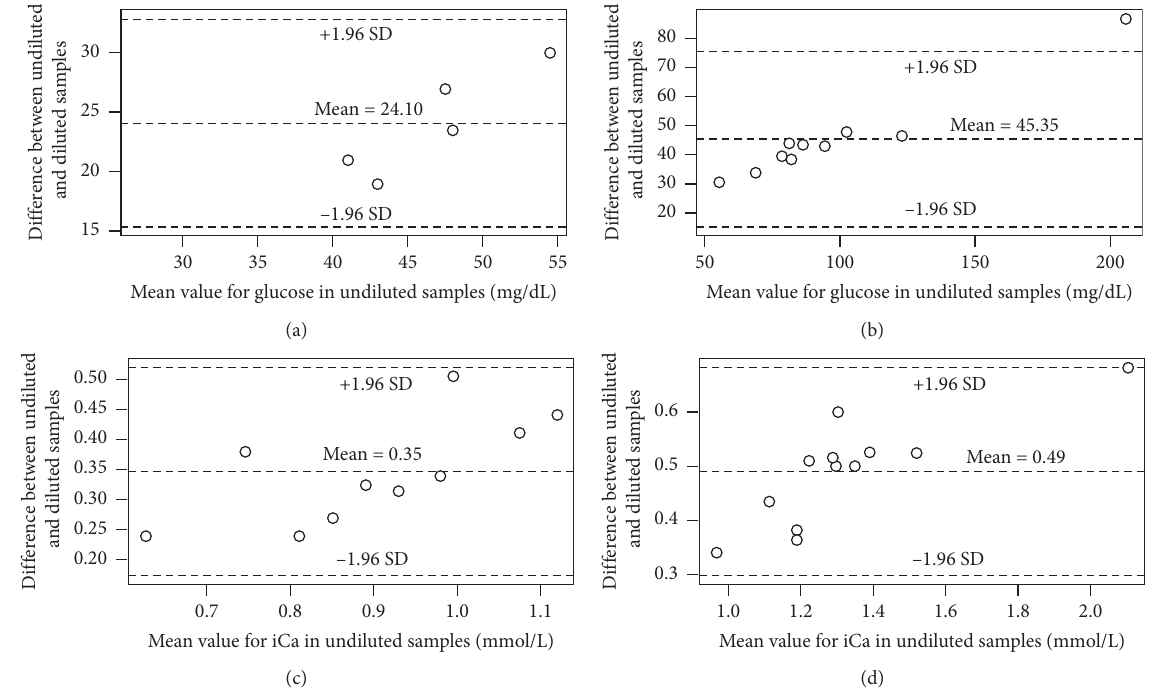
Figure 2: Bland–Altman plots showing the difference between undiluted and diluted samples compared to mean value of undiluted samples, for marine toad ( Rhinella marinus ) (a, c) and eastern box turtle ( Terrapene carolina carolina ) (b, d), and for glucose (a, b) and ionized calcium (c, d). Lines of agreement are shown as ± 1.96 standard deviation